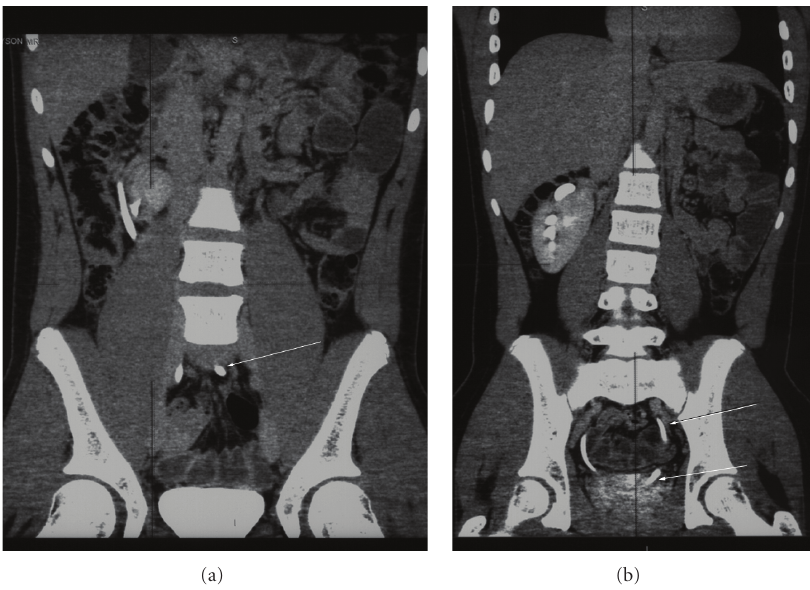
Figure 3: 16-year-old adolescent male with left-to-right crossed renal ectopia. Coronal CT scan with intravenous contrast-delayed phase demonstrates the left ectopic ureter crossing midline (white arrow in (a)), to insert onto left side bladder (white arrows in (b)).